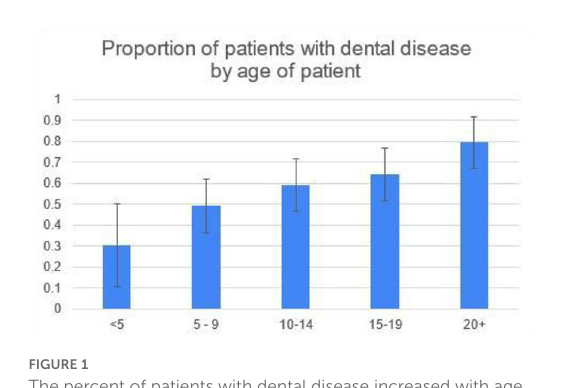
FIGURE1 The percent of patients with dental disease increased with age, significant at the 5% level using a Chi-squared test for linear